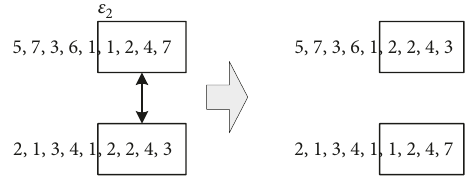
Figure 5: Chromosome crossover operation.